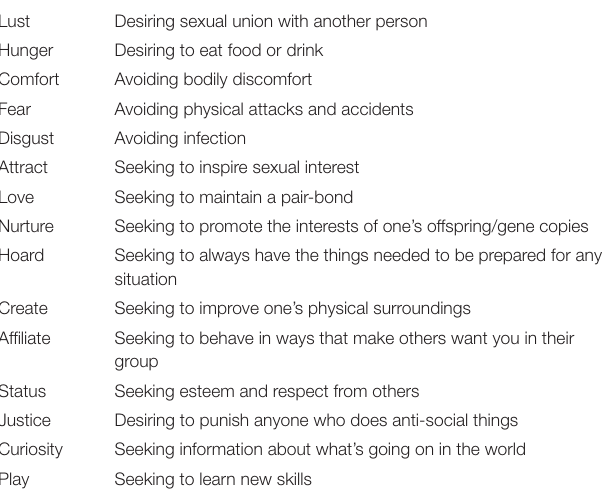
TABLE 1 | The evolved human